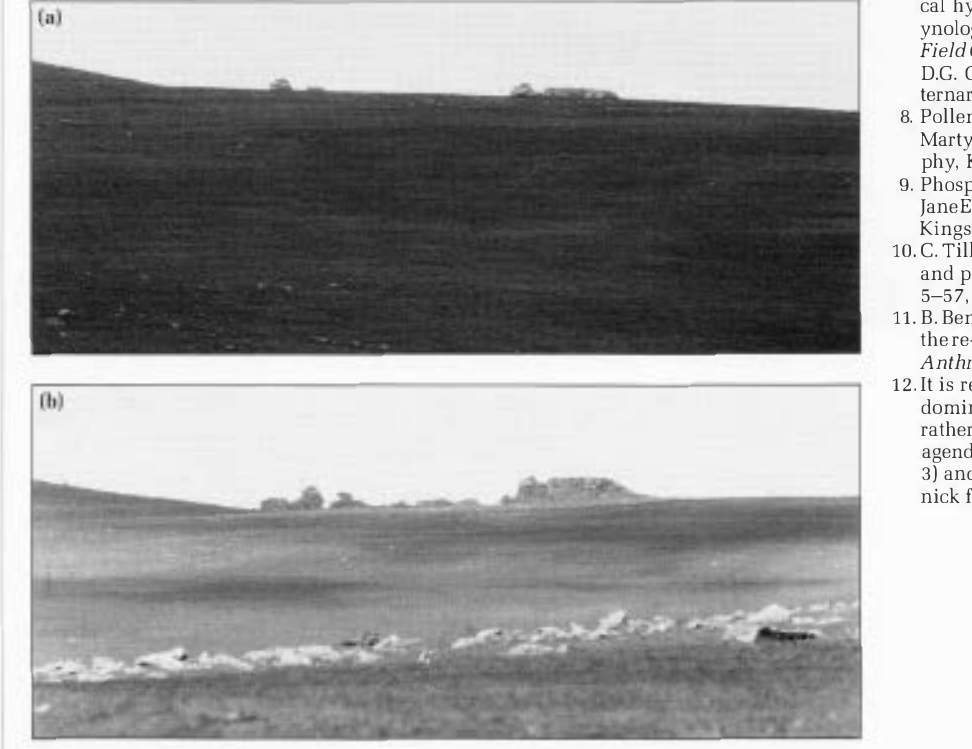
Figure 9 Emergence of Rough Tor on the skyline as one approaches (a) and arrives at (b) the Stone Row Terminal at Leskernick.